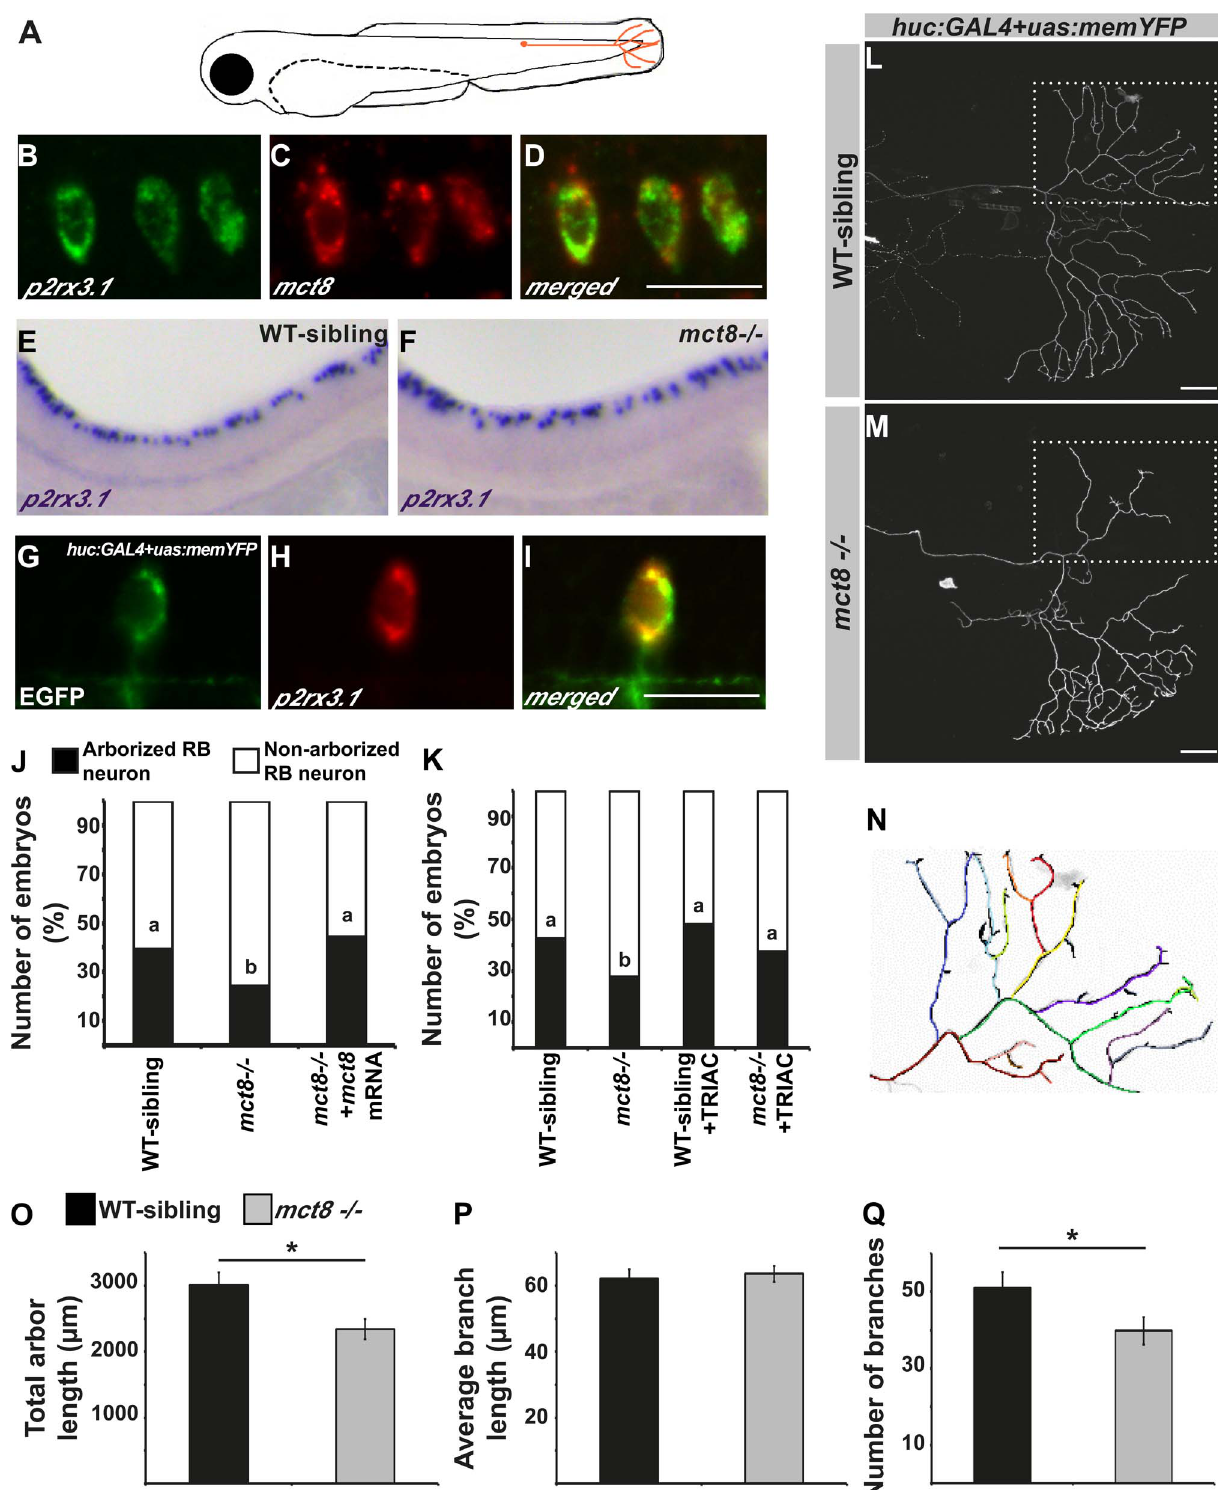
Figure 7. MCT8 regulates axon branching in the Rohon-Beard sensory neurons. A . A representative scheme of the Rohon-Beard (RB) sensory neuron location in zebrafish larvae. B–D . Double fluorescent ISH in 33 hpf embryos revealed co-localization of p2rx3.1 (green) and mct8 (red) in RB cell bodies. E–F . Whole mount ISH showed the spatial expression of p2rx3.1 in the dorsal spinal cord of 2 dpf WT-sibling ( E ) and mct8 2 / 2 larvae ( F ). G–I . Whole-mount ISH and immunofluorescence revealed co-localization of EGFP (green) and p2rx3.1 (red) in the cell body of an RB neuron in 2 dpf huc:GAL4 + uas:memYFP -injected embryos. J . The percentages of embryos that express memYFP in single arborized RB neurons in the tail (black bars), are shown in 2 dpf WT-sibling, mct8 2 / 2 and mct8 mRNA-injected mct8 2 / 2 embryos. Statistical significance was determined by the Chi square test. Different letters indicate significant difference. K . The percentages of embryos that express memYFP in single arborized RB neurons in the